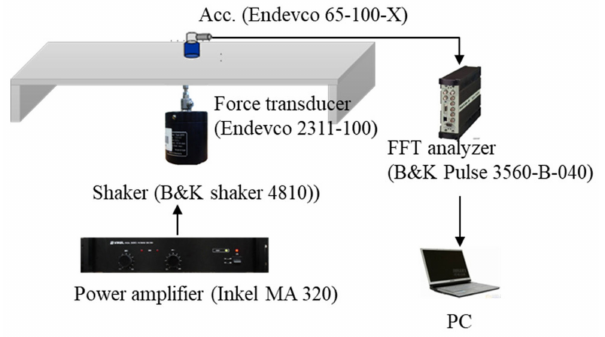
Figure 2. Experimental setup for modal test.